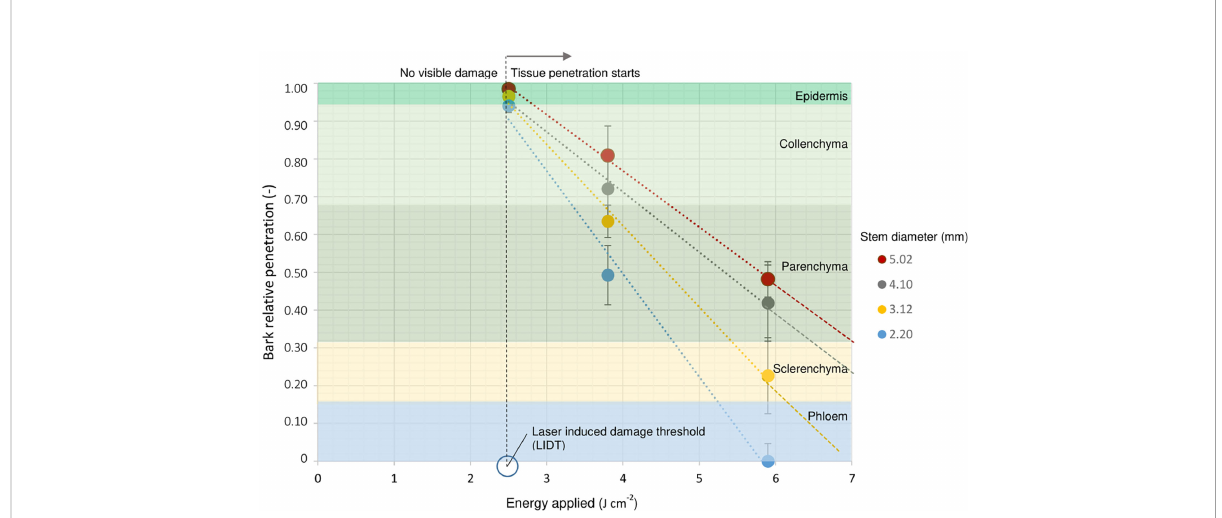
FIGURE 7 Laser penetration relative to the bark thickness in terms of energy applied for R. canina ‘ Pfänder ’ R02-6 cuttings depending on stem diameter. The different tissue layers that compose rose bark are represented in different colors and arranged in proportion to their original dimension in the bark. The vertical broken black line describes the laser induced damage threshold (LIDT) determined at 2.5 J cm -2 . Dots represent the penetration mean values with SE, n =